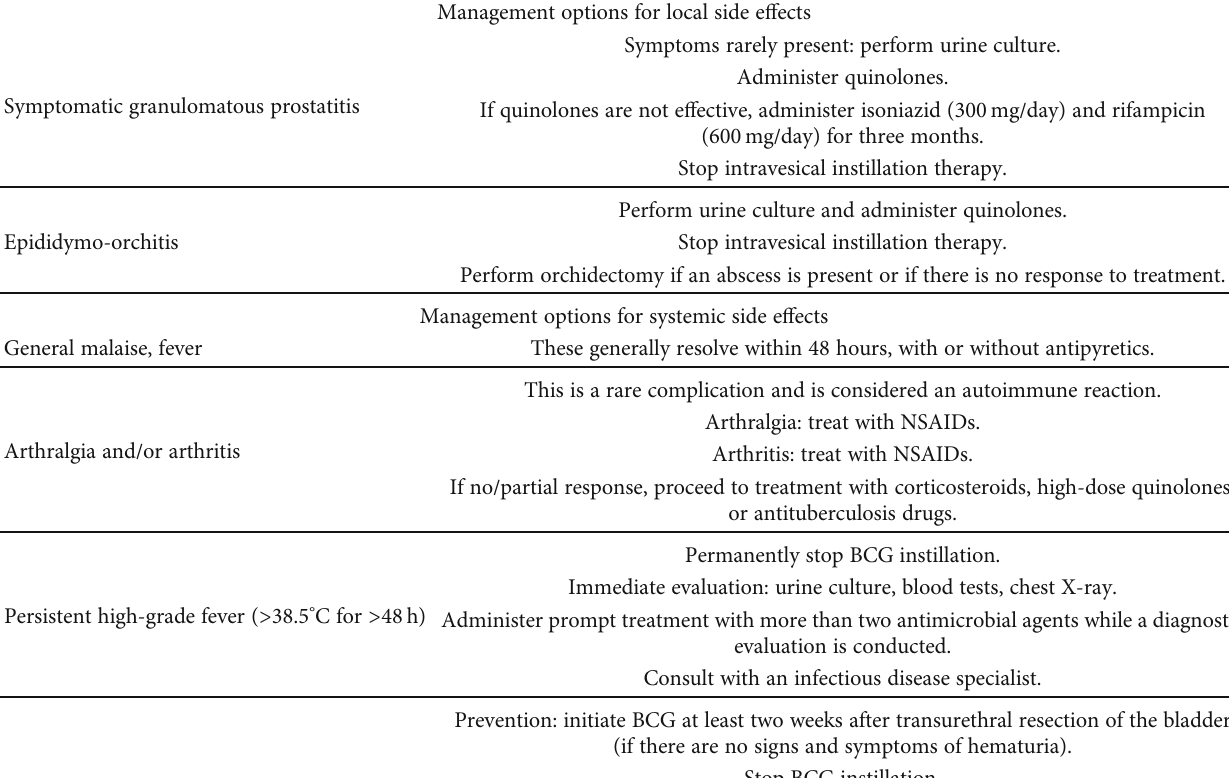
Table 2: Management options for treating the side e ff ects of Bacillus Calmette-Guérin intravesical instillation therapy. Management options for local side e ff ects